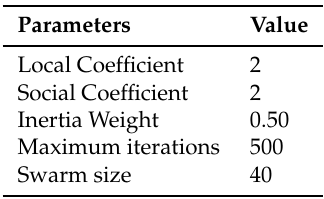
Table 4. PSO Parameters